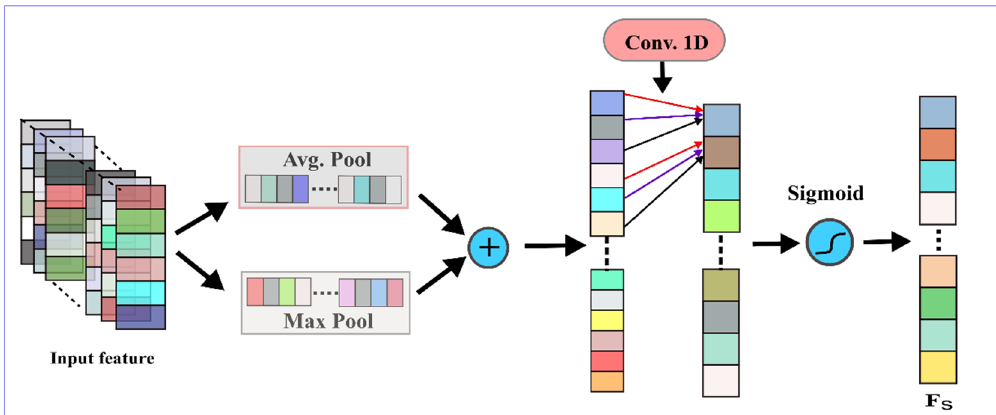
Figure 5. The schematic diagram of the FAM.